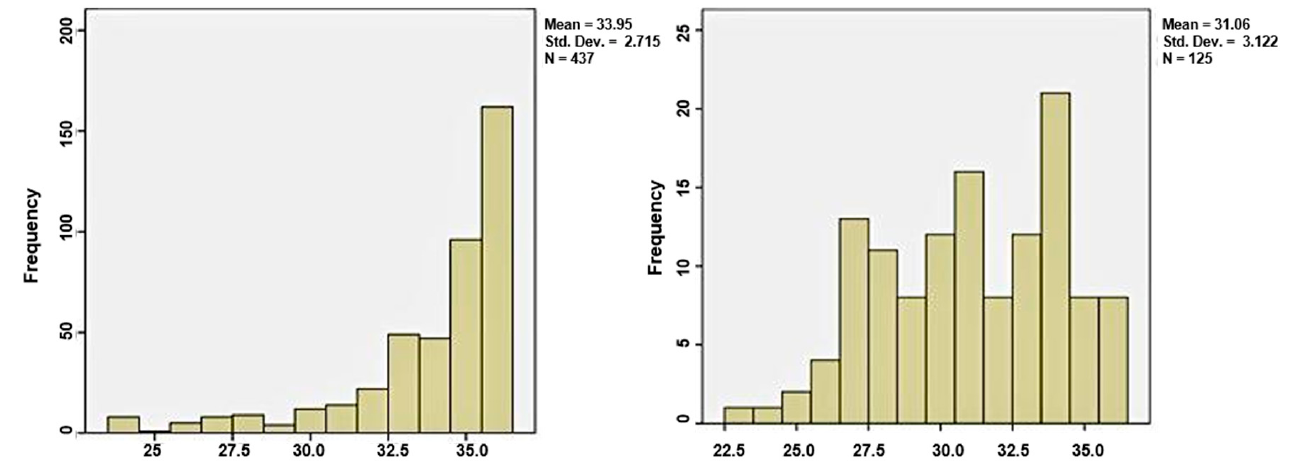
Figure 2. Distribution of gestational age in the two groups; ( a ) the distribution of gestational age in group 1; ( b ) the distribution of gestational age in group 2.